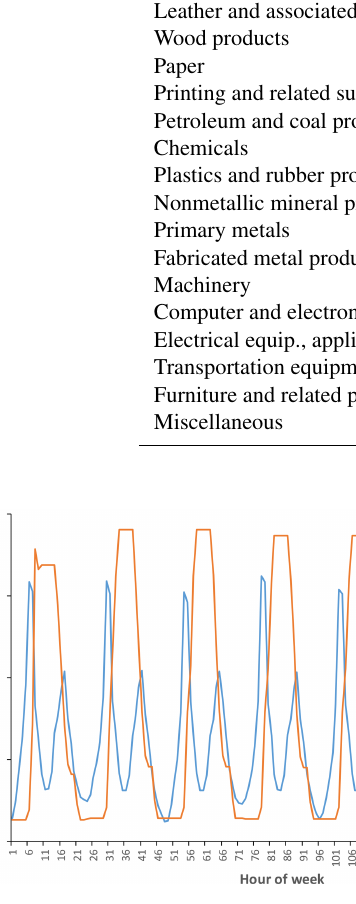
Figure 3. Energy consumption intensity (hourly fraction) from an eQUEST simulation of the average week in 2011 for two types of buildings: “single-family detached house” and